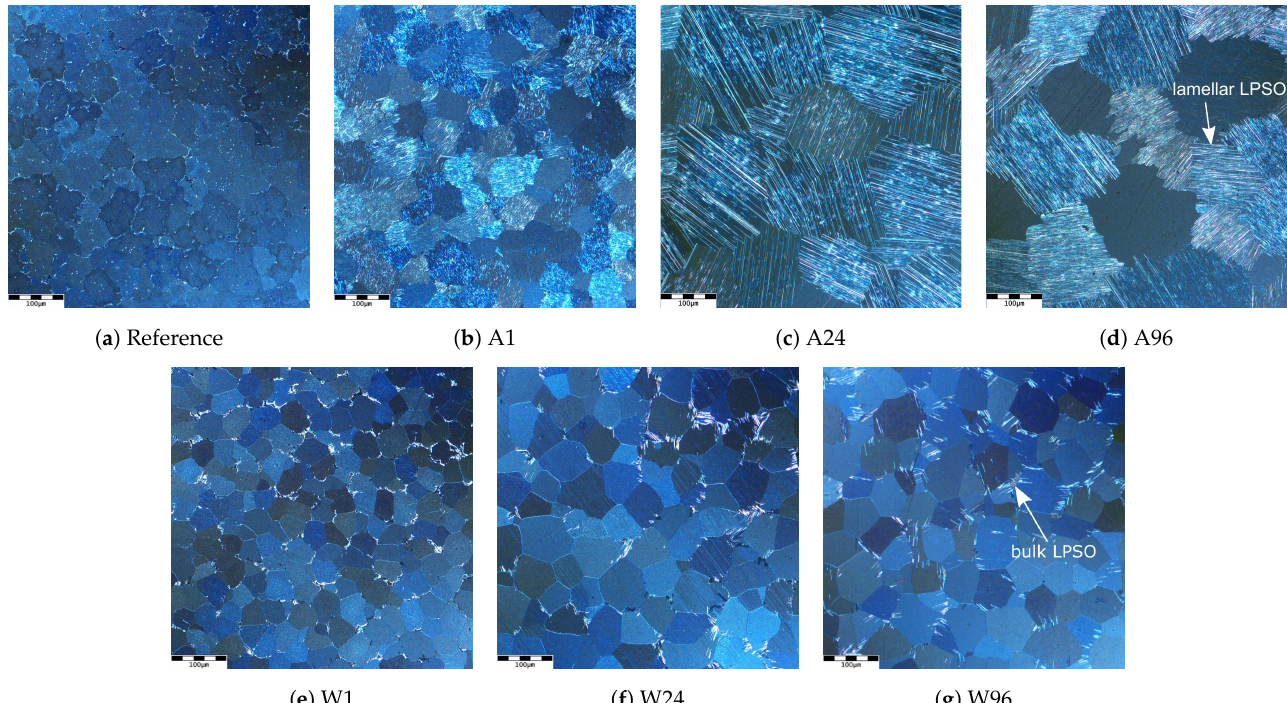
Figure 2. Light microscopy images of the platelets depending on the heat treatment duration and the cooling conditions ( a – g